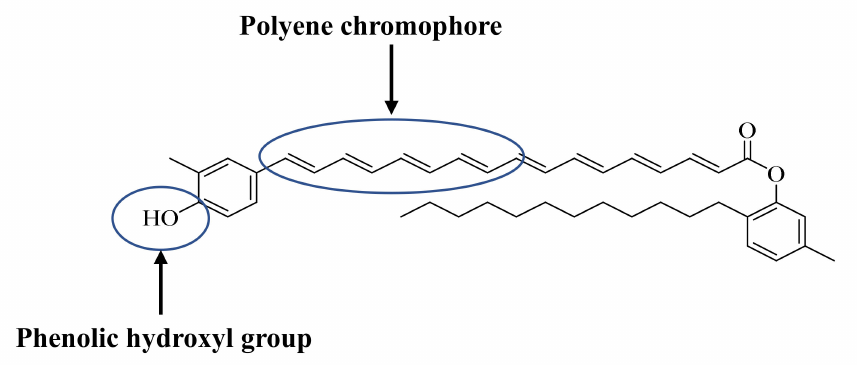
Figure 1. Flexirubin structure comprising of polyene chromophore and phenolic hydroxyl group proposed using ChemBioDraw Ultra